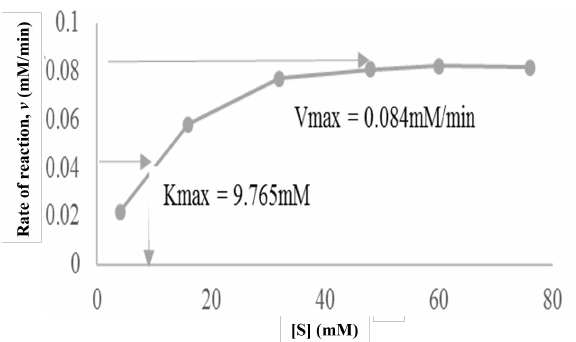
Fig. 4. The Michaelis–Menten saturation curve of ANAE